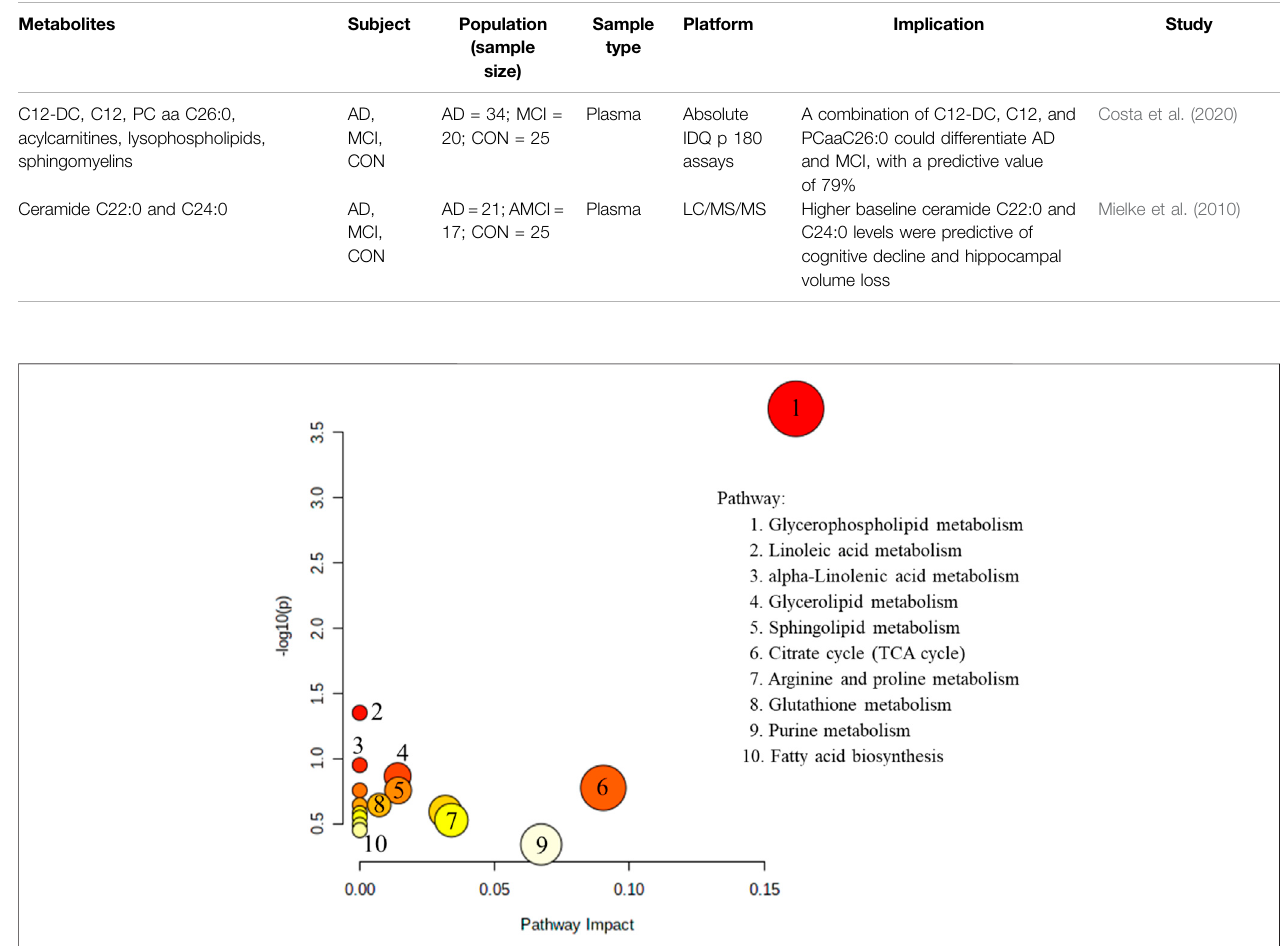
FIGURE 4 | The metabolites reported in the brain and blood ( Tables 2 , 3 , excepted small molecular amino acid) view analyzed by MetaboAnalyst 5.0.